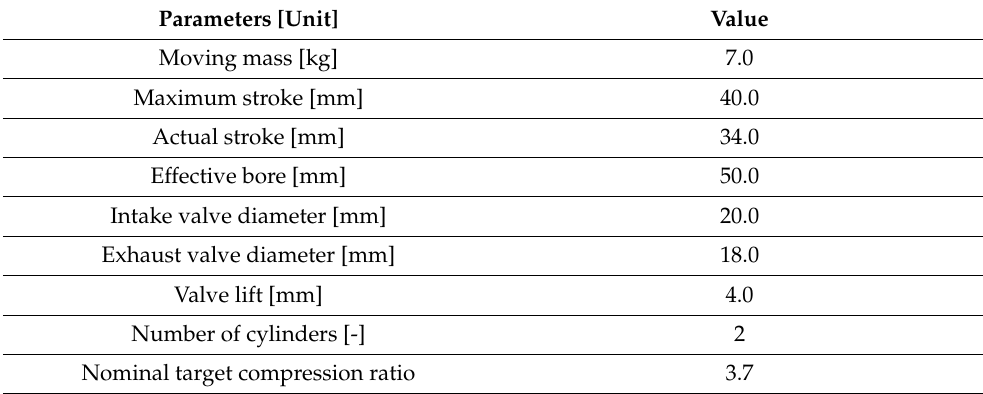
Table 4. Hydrogen FPE prototype